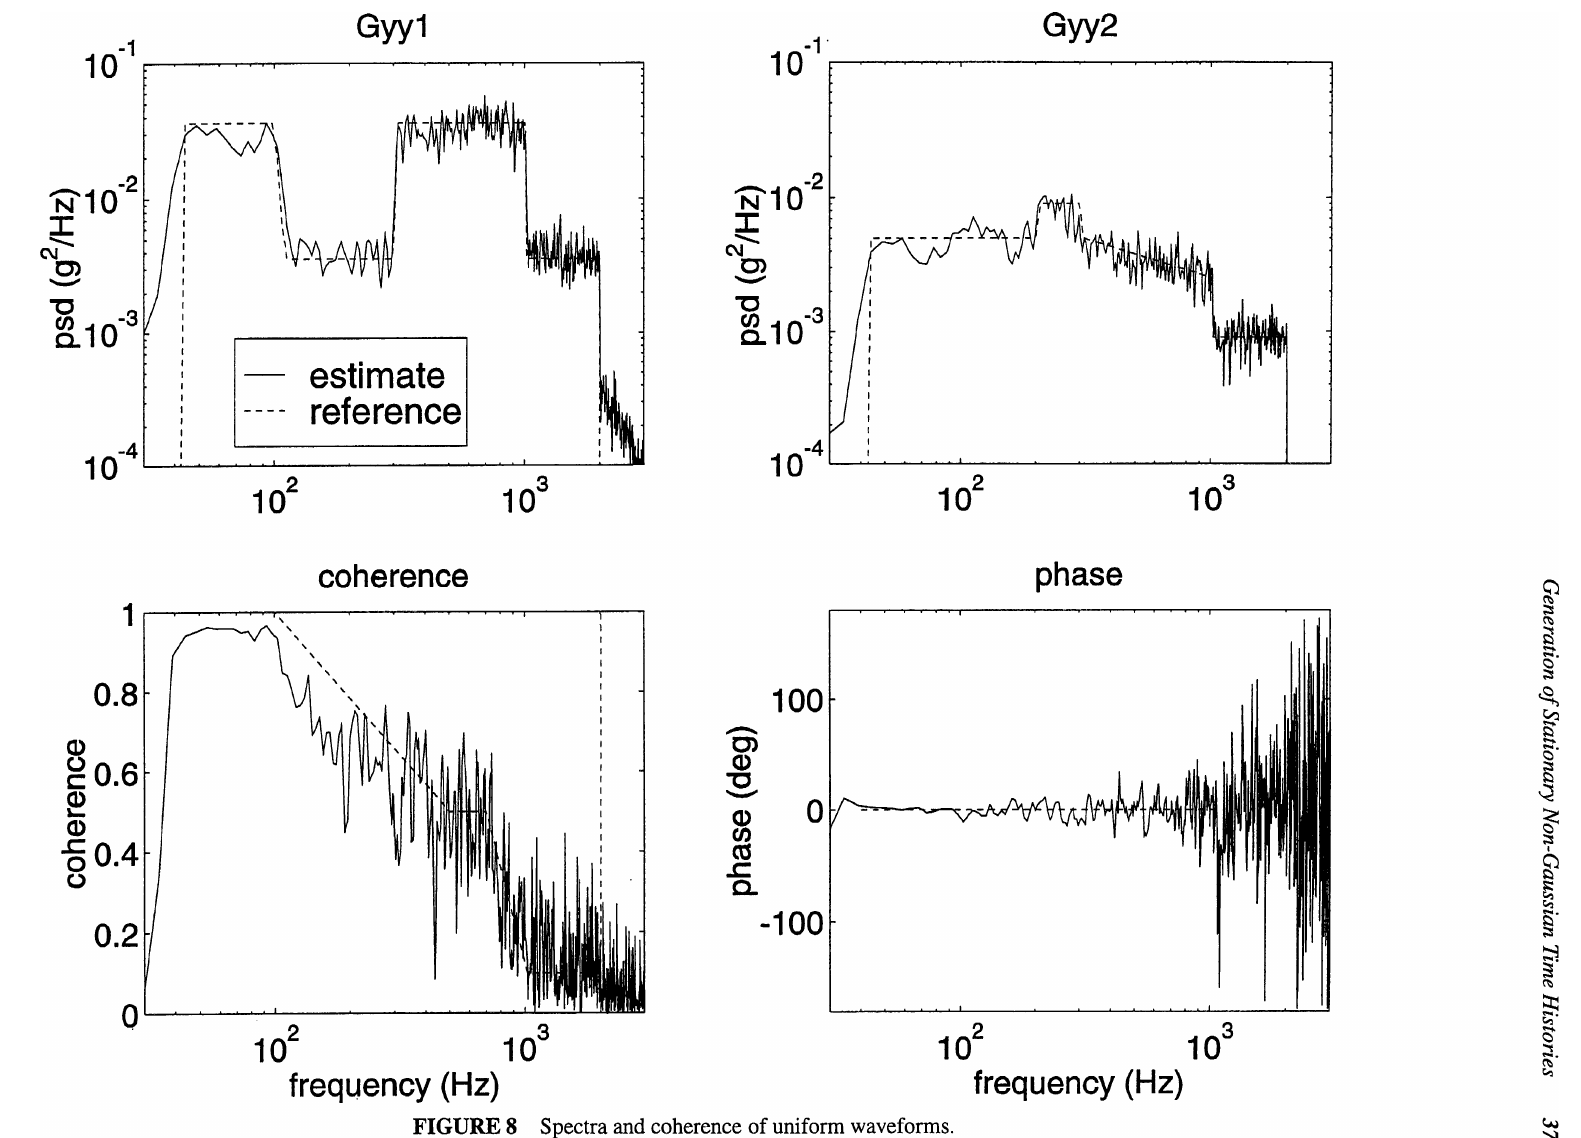
FIGURE 8 Spectra and coherence of uniform